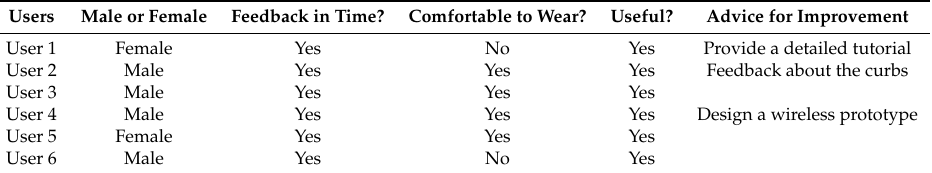
Table 7. The questionnaire.